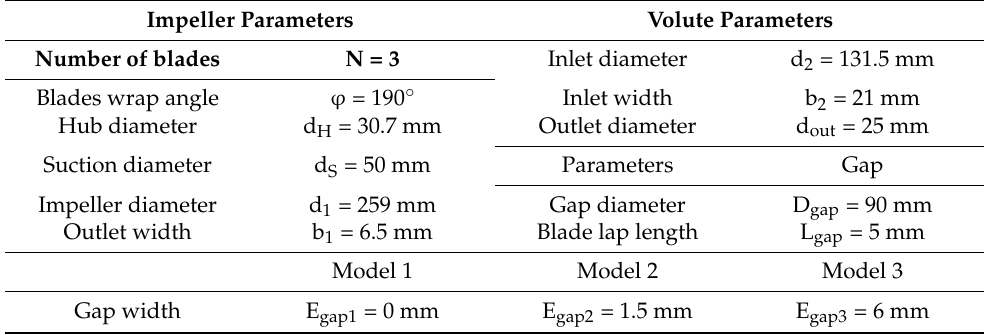
Table 1. Geometric specifications of the impeller and